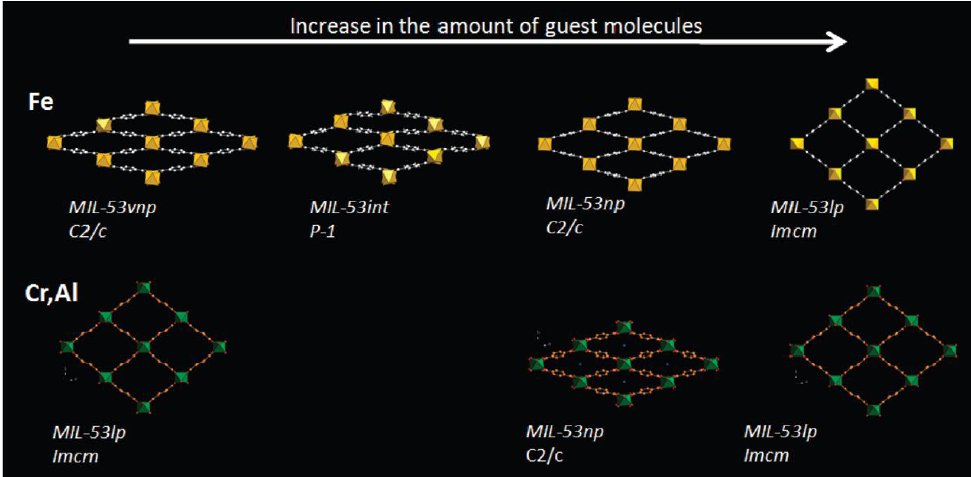
Figure 16. Schematic diagram of structural evolutions of MIL-53(Fe) and MIL-53(Al, Cr) upon adsorption of n -alkanes. Reprinted with permission from [106]. Copyright 2009 American Chemical